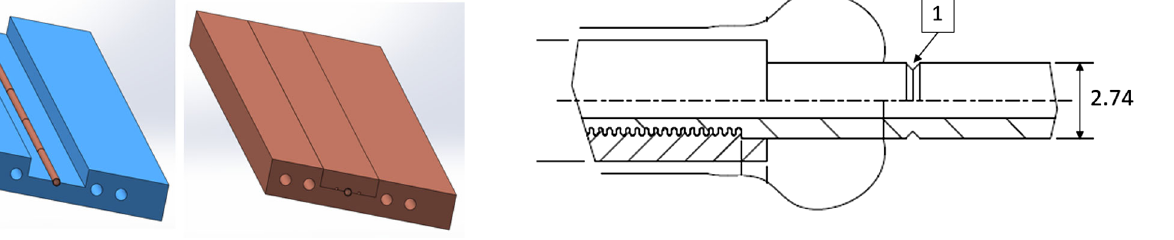
FIG. 5. Drawing of the end of the plated mandrel showing the diameter of the masked aluminum in millimeters and the location of the reference groove